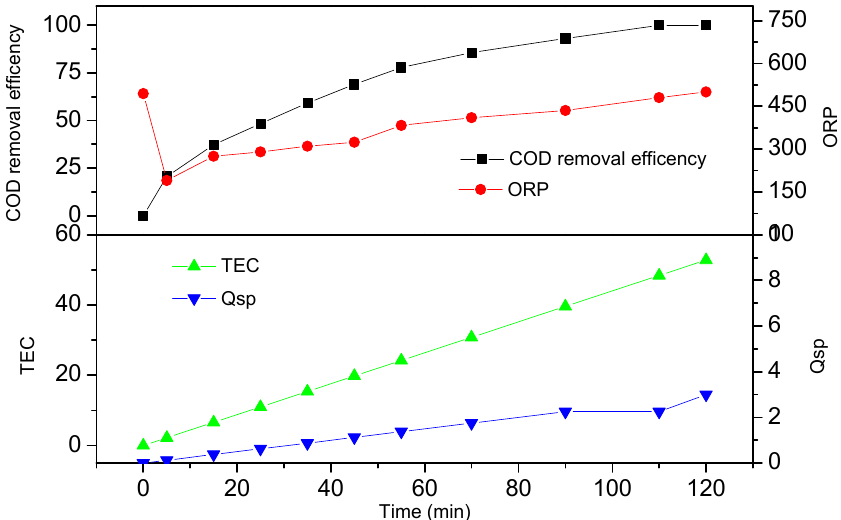
Figure 4. COD removal efficiency, ORP, total energy consumption (TEC), and Qsp under a current density of 15 mA cm − 2 , original pH of 3, and an Na 2 SO 4 concentration of 0.10 mol L − 1 .